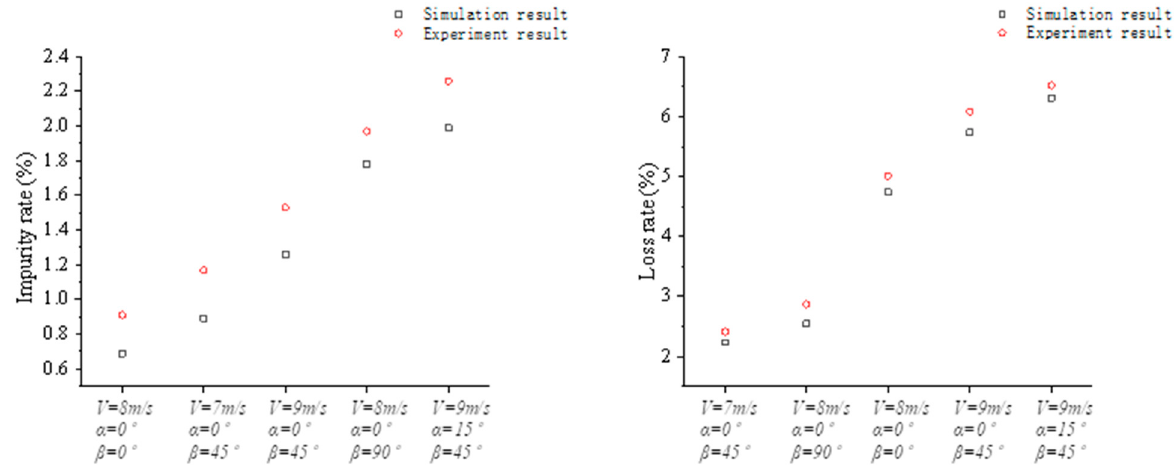
Figure 9. Comparison diagram of cleaning efficiency between simulation and experiment.